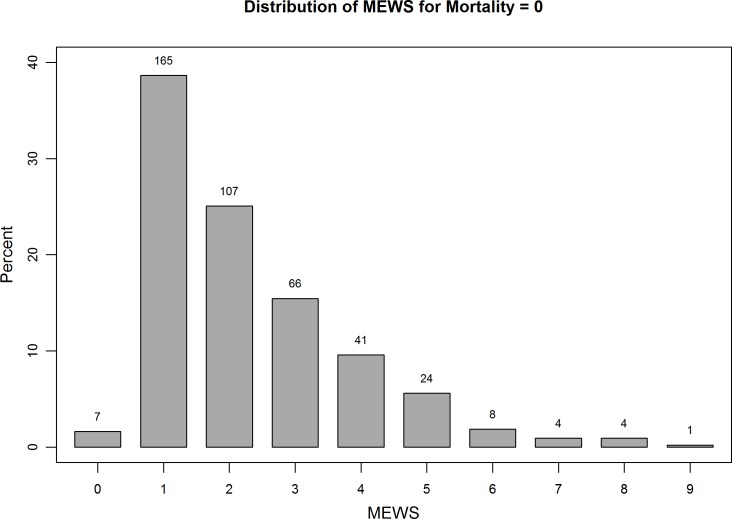
Distribution of MEWS across all patients who survived.Modified Early Warning Scores were calculated for all patients, and the majority of patients who survived had a MEWS of 1, as illustrated in this distribution of MEWS across all surviving patients.